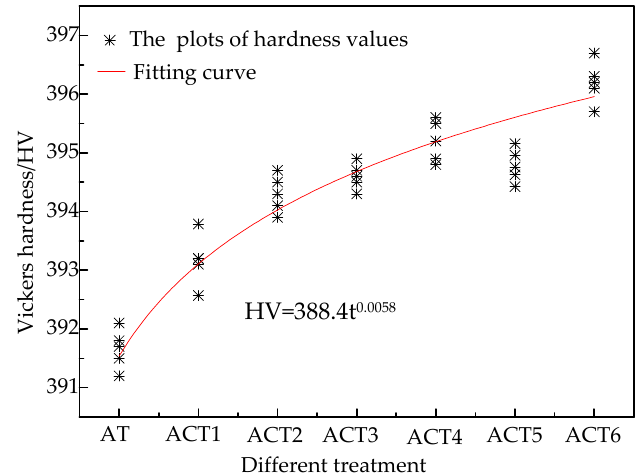
Figure 7. Variation of Vickers hardness with different treatment.